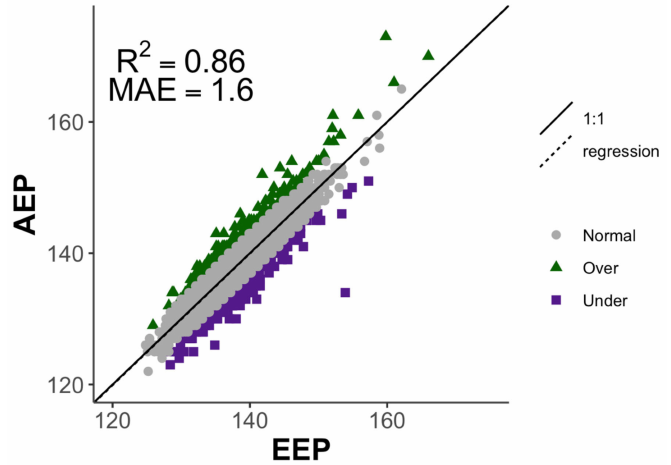
Figure 3. AEP regressed on EEP predicted from Model 1 with the regression and 1:1 line and the 90% confidence limits displayed. Over- and underperformance points outside of the 90% confidence interval capture the influence of land management practices and disturbances (overgrazing, fire, irrigation, etc.) while the normal points represent the inherit noise in the